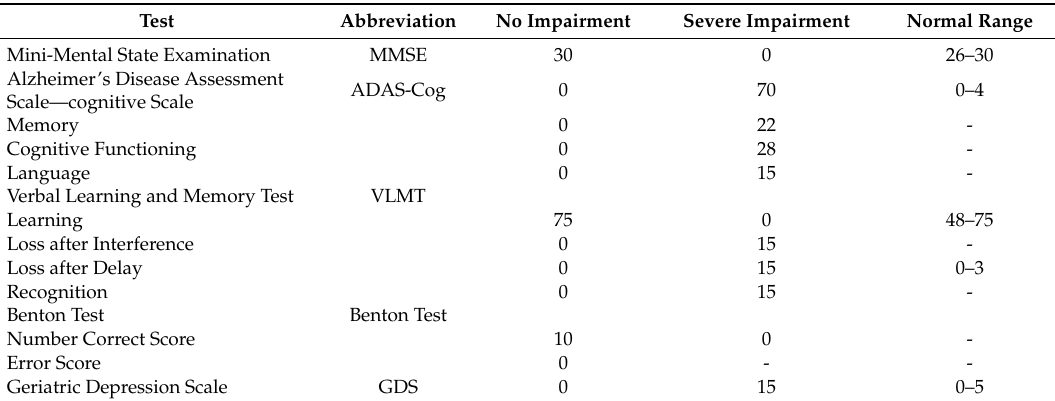
Table 3. Assessments by standardized